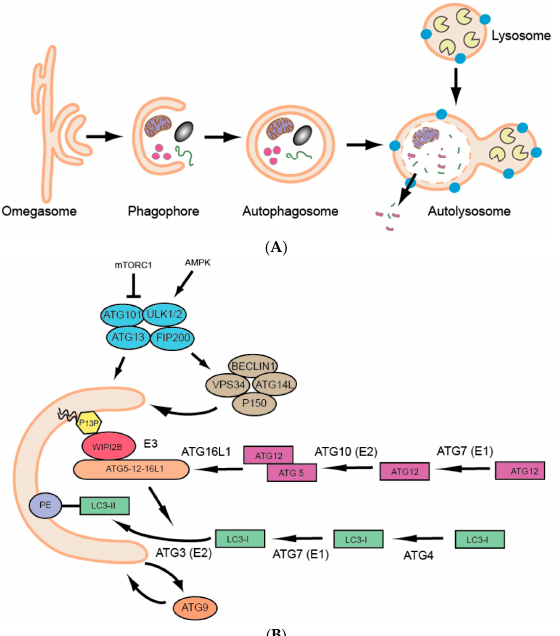
Figure 1. ( A ) Schematic overview of the process of macroautophagy; ( B ) Schematic overview of the core autophagic proteins involved in autophagosome biogenesis. core autophagic proteins involved in autophagosome